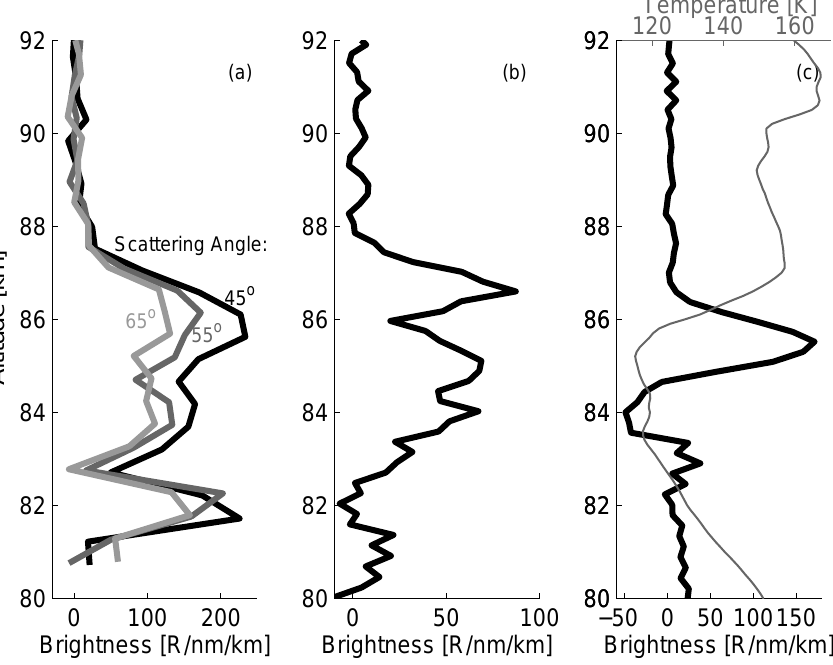
Fig. 3. Vertical NLC profiles. Panel (a) shows the MASS1 upleg for three different scattering angles. The vertically extended structure with three peaks is seen at all angles, and as expected the signal decreases with scattering angle. Panel (b) displays the ECOMA upleg. This also shows a high and extended structure. Attitude problems at lower altitudes together with the noise level make it unclear if the structure below 82km is real or not. Panel (c) shows the ECOMA downleg profile, one single confined layer centred at 85.5km. Temperature from the CONE instrument (Strelnikov et al., 2009), also measured on the downleg, is shown by the thin gray line in